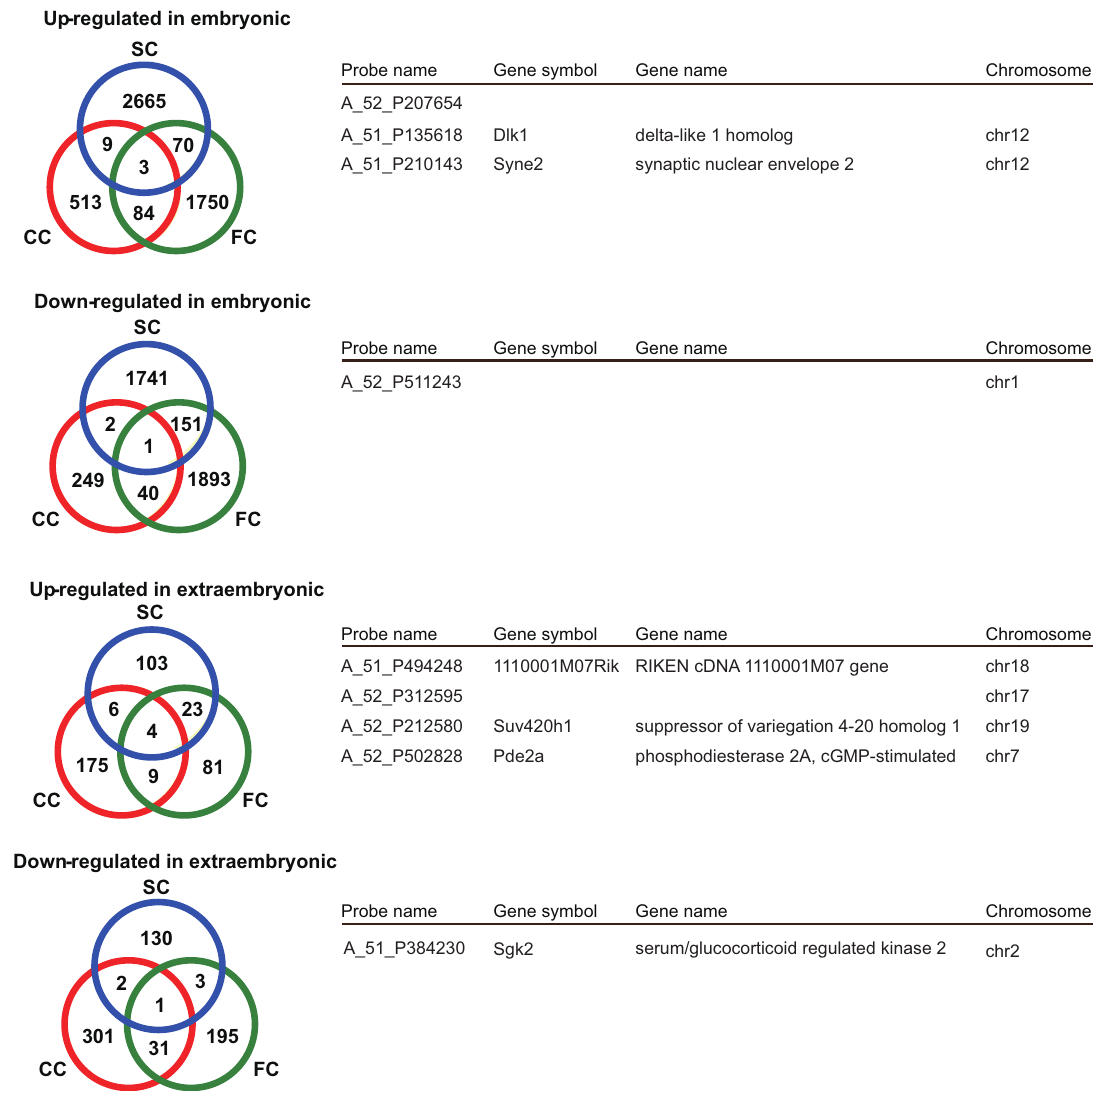
Figure 5. Overlapping DEGs among the three SCNT groups. ( A ) Venn diagrams of the DEGs identified in Figure 3 (fold change . 2.0), showing the numbers of shared and unique DEGs among three different SCNT groups. There were very few DEGs shared with all three groups in both embryonic and extraembryonic tissues. ( B ) List of overlapping DEGs among the three SCNT groups. A complete list of DEGs is shown in Table S2.